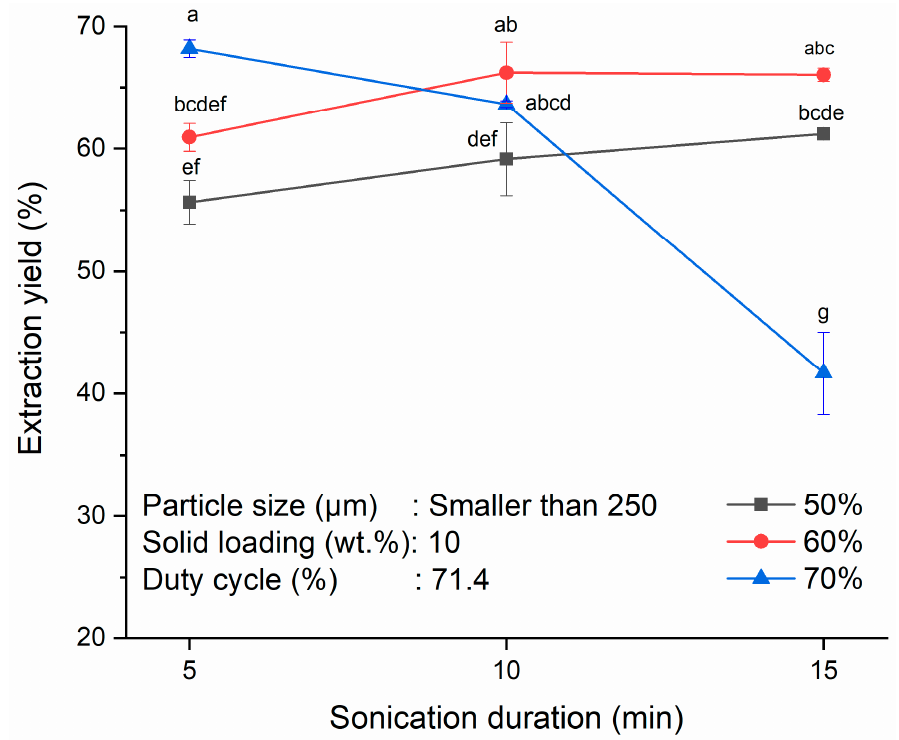
Figure 3. Effects of sonication durations (5, 10 and 15 min) and ultrasonic amplitudes (50, 60 and 70%) on extraction yield of starch from SPW. Different letters indicate the values are significantly different ( p < 0.05).